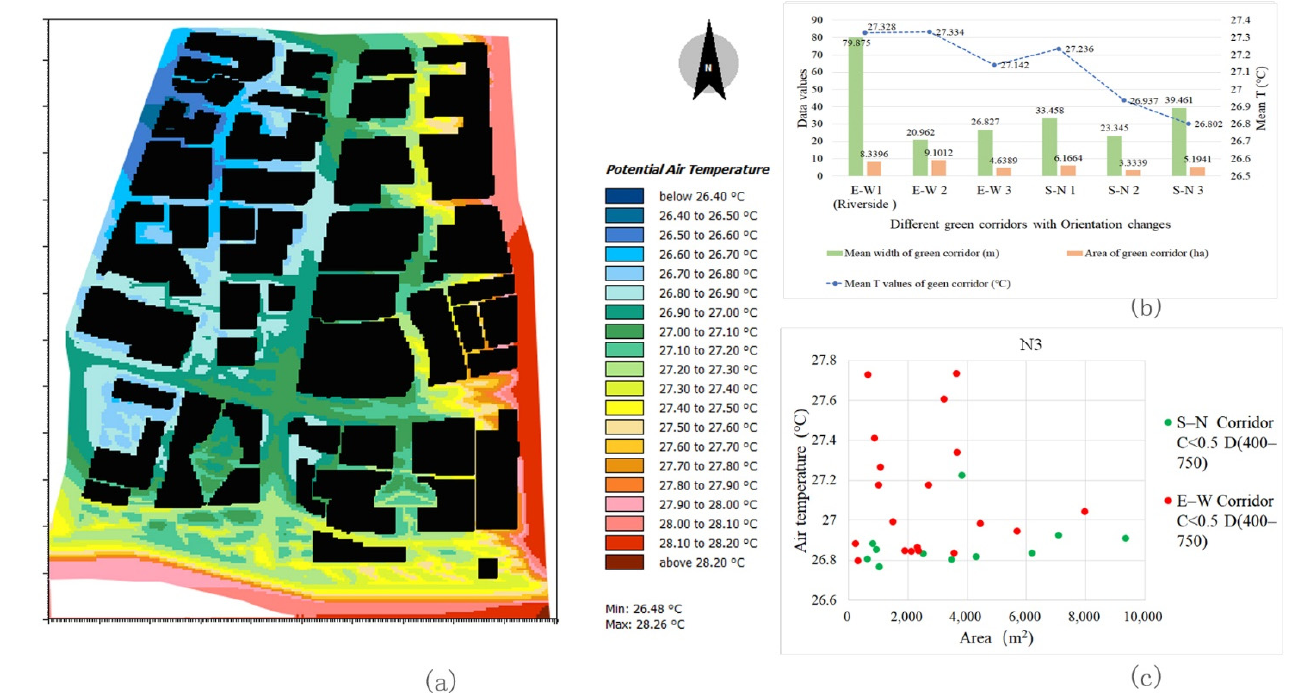
Figure 10. Ta distribution status of green corridors with different orientations at 14:00 and 1.5 m height in block N2 and comparison of the Ta difference of each green corridor segment. ( a ) Spatial distribution of Ta using ENVI-met simulation. ( b ) Comparison of mean temperatures of nine green corridors inside the block. The green corridor number is shown in Figure 2b. It can be seen that the blue-green corridors downwind of the SE–NW orientation have a significant impact on the Ta of the connected green corridors with an SW–NE orientation in the riverfront district. This blue-green spatial ori- entation factor affected the holistic cooling characteristics of the region such that the Ta values of the green corridors with an SW–NE orientation are mostly lower than the internal temperatures of the green corridors with an SE–NW orientation. ( c ) Comparison of Ta scatter distribution of two groups of green corridors with different orientations, the same grade of D factor and similar connection degree. It can be observed that most of the internal Ta of green corridors with an SW–NE orientation (marked by square points) are located below the internal Ta of green corridors with an SE–NW orientation (marked by circular points), which are relatively low.